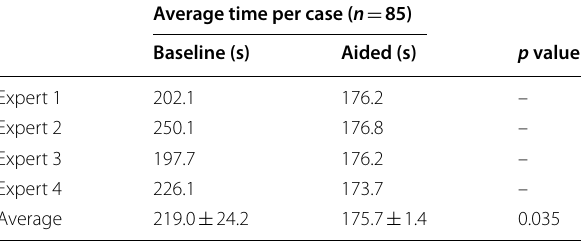
Total time for each reader in each session was recorded and the averaged case- reading time was calculated. Average time for each session was expressed in mean standard deviation and was compared with paired Student’s t ±